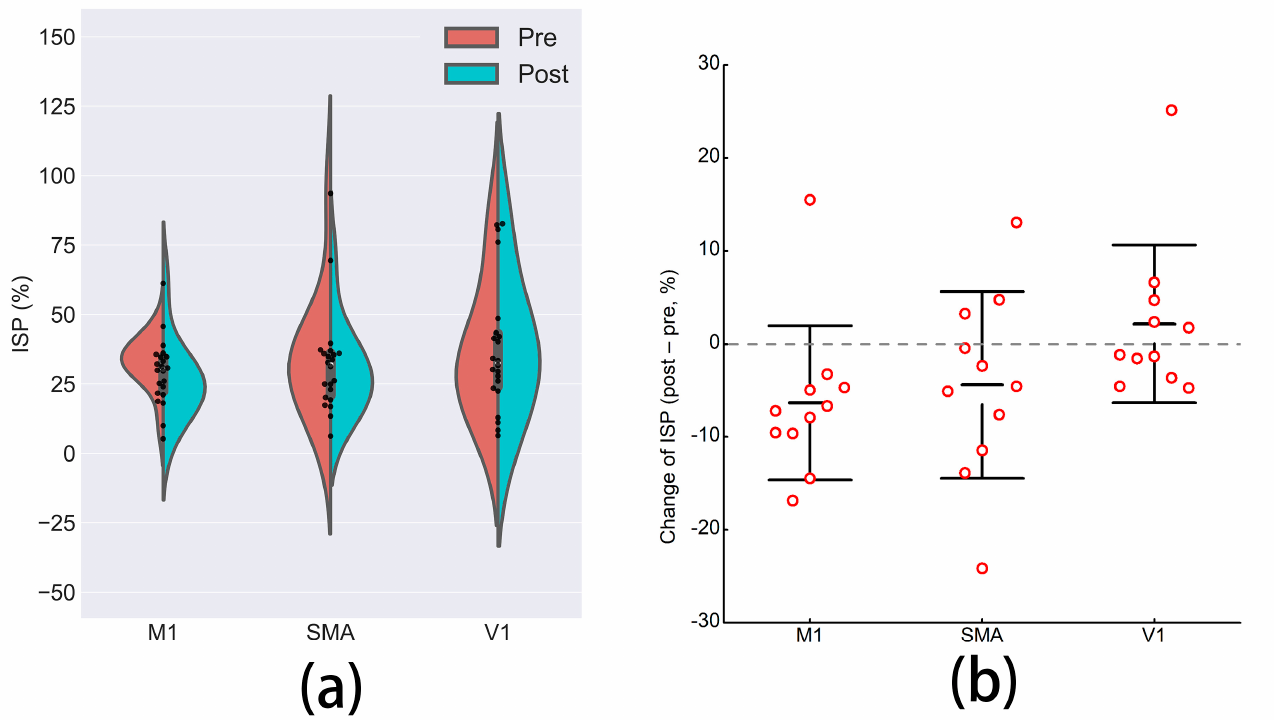
Figure 4. The effects on TMS-induced interhemispheric signal propagation. ( a ) The difference in TMS-induced interhemispheric signal propagation pre- and post-iTBS to the three brain regions. ( b ) Comparisons of the change of ISP among the three conditions. Error bars are standard diversions. ISP: interhemispheric signal propagation; M1: primary motor cortex; SMA: supplementary motor area; V1: primary visual cortex.